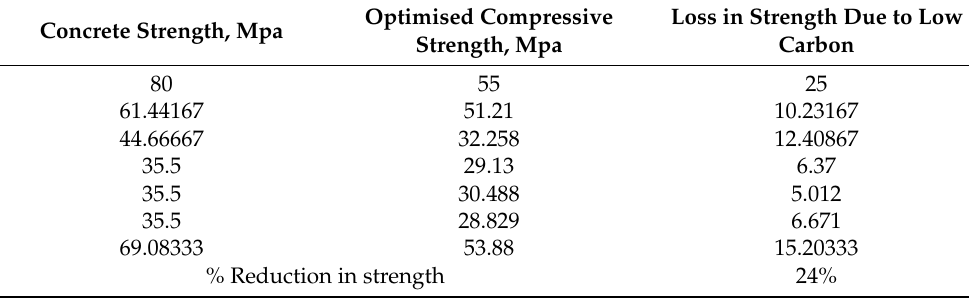
Table 17. Summary of the optimised compressive strength using the LP Program.